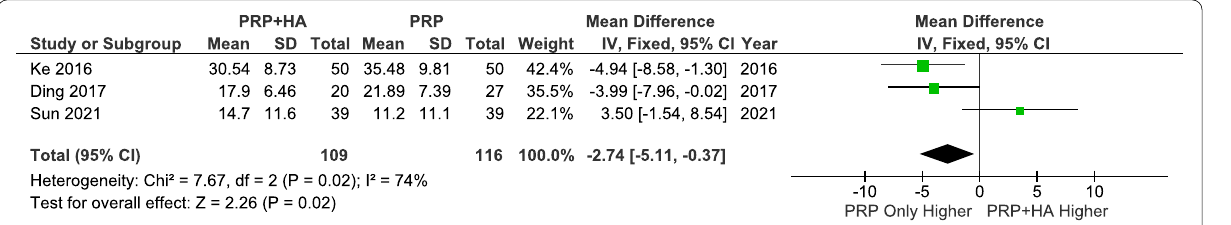
Fig. 11 Showing the Forest plot comparing the WOMAC function scores between PRP